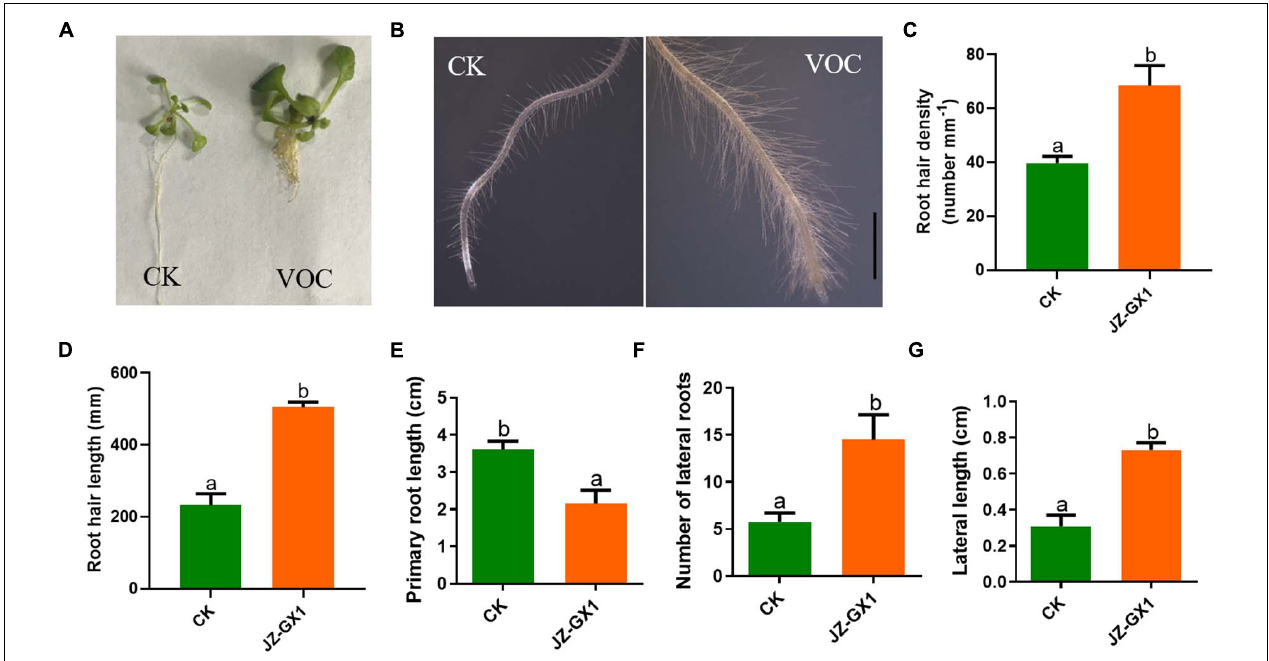
FIGURE 2 | Effect of Rahnella aquatilis JZ-GX1 VOCs on the root system architecture of Arabidopsis thaliana compared to the control (CK) under iron deficiency stress. (A) The overall structure of the root system, (B) root hair morphology, (C) root hair density, (D) root hair length, (E) primary root length, (F) lateral root number, and (G) lateral root length. The scale is 0.5 mm. One-way ANOVA was performed, and Duncan’s post hoc test was applied. Different letters indicate statistically significant differences ( p < 0.05) among